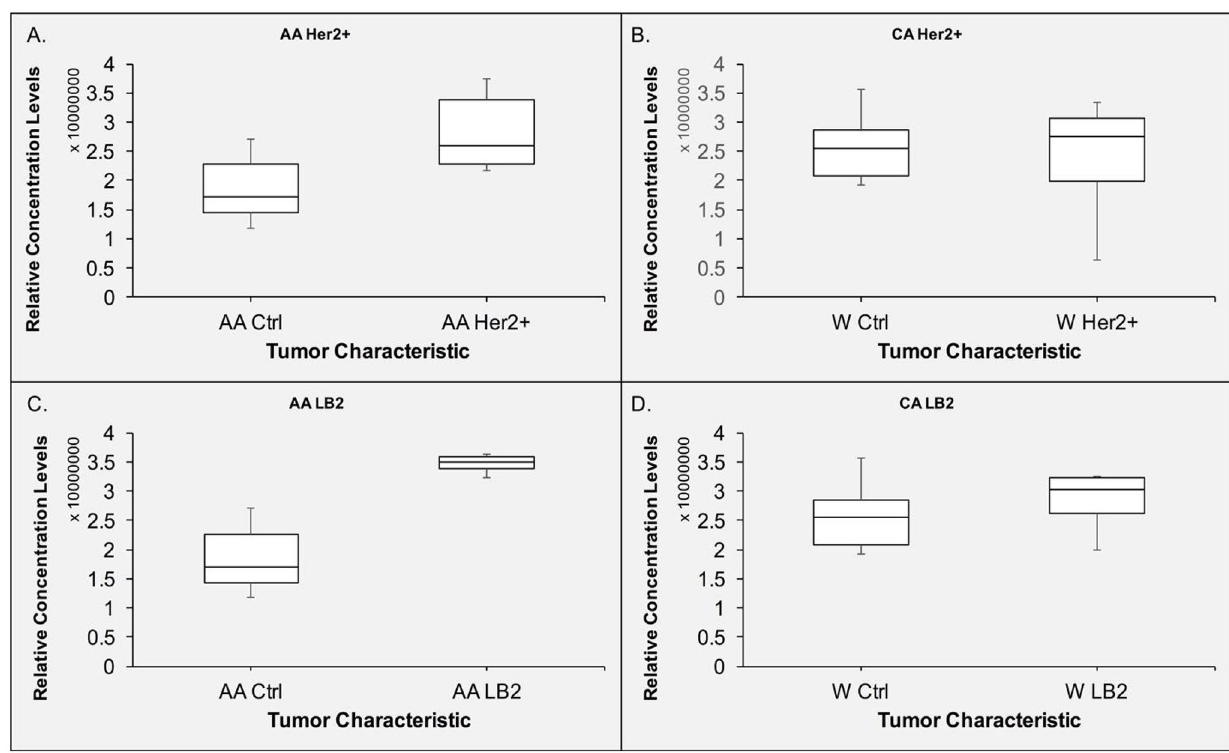
Fig 3. Validation of RPPA data and assessment of racial disparities in serum concentration levels of vitronectin in Her2+ and LB2 tumor subtypes. The data above is validation of data shown in Fig 2, that showed potential racial disparities in tumor subtypes in vitronectin concentration levels of serum. A . Displays the relative concentration levels of vitronectin in AA Her2+ patients in serum compared with corresponding control samples. B . Relative serum concentration levels of vitronectin in WA Her2+ patients and compared with healthy patients C . Displays the relative serum concentration levels of vitronectin in AA LB2 patients and control serum. D . Displays the relative concentration levels of vitronectin in CA LB2 patients in serum.